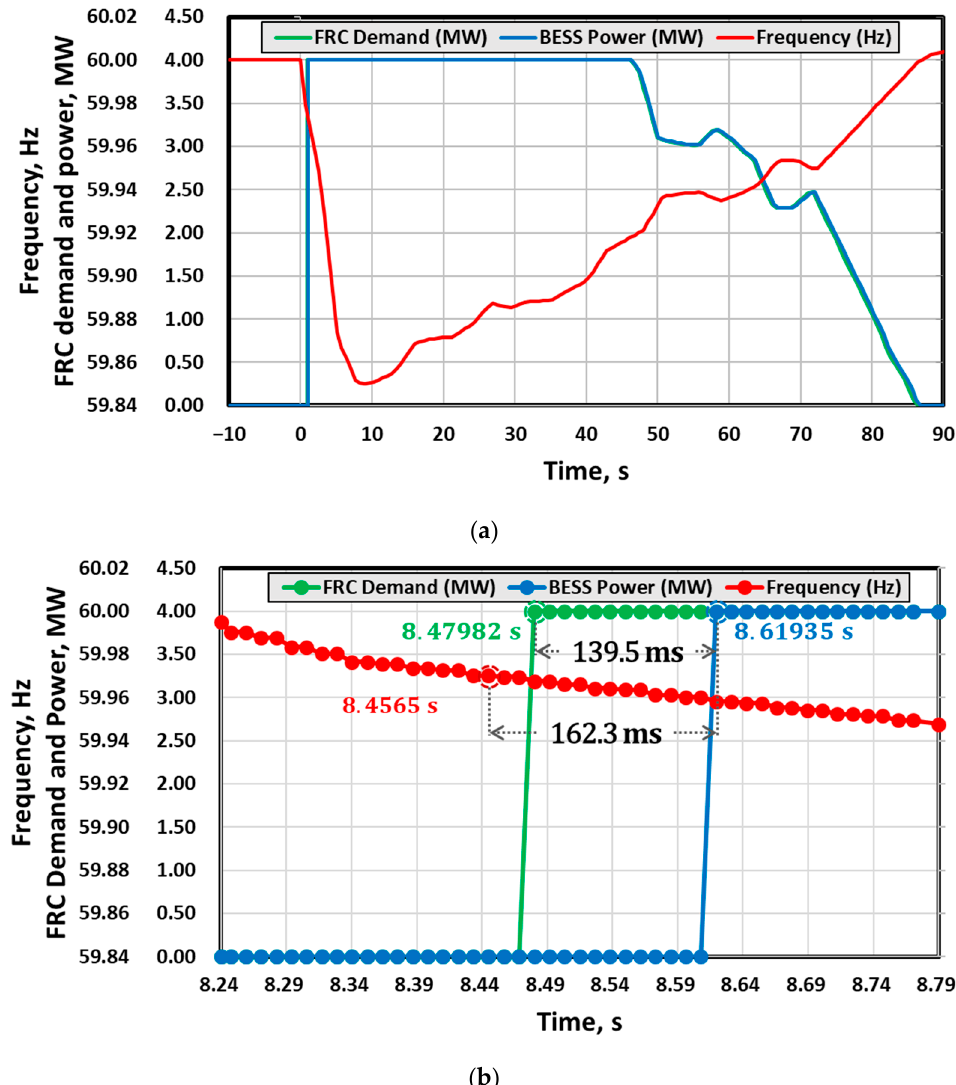
Figure 13. Result of FRC’s response performance evaluation by Iba Analyzer in Non-gong substation; ( a ) Entire period; ( b ) BESS response starting point.